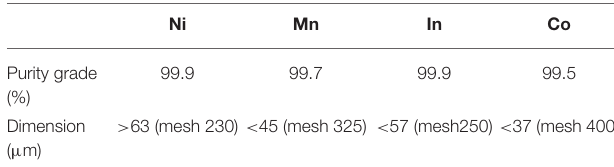
TABLE 1 | Characteristics of the powder reagents used to obtain the compacted precursors.